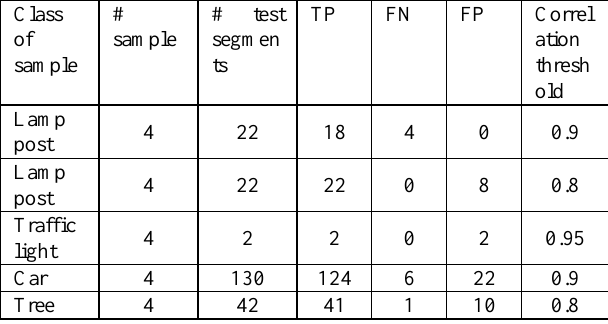
Table 1 Accuracy results for detecting objects using 4 samples per class.